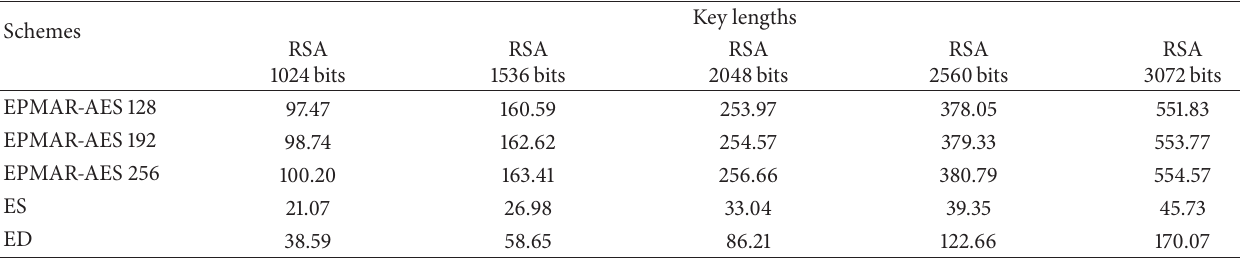
Table 8: Total computational time—offline transaction (ms).